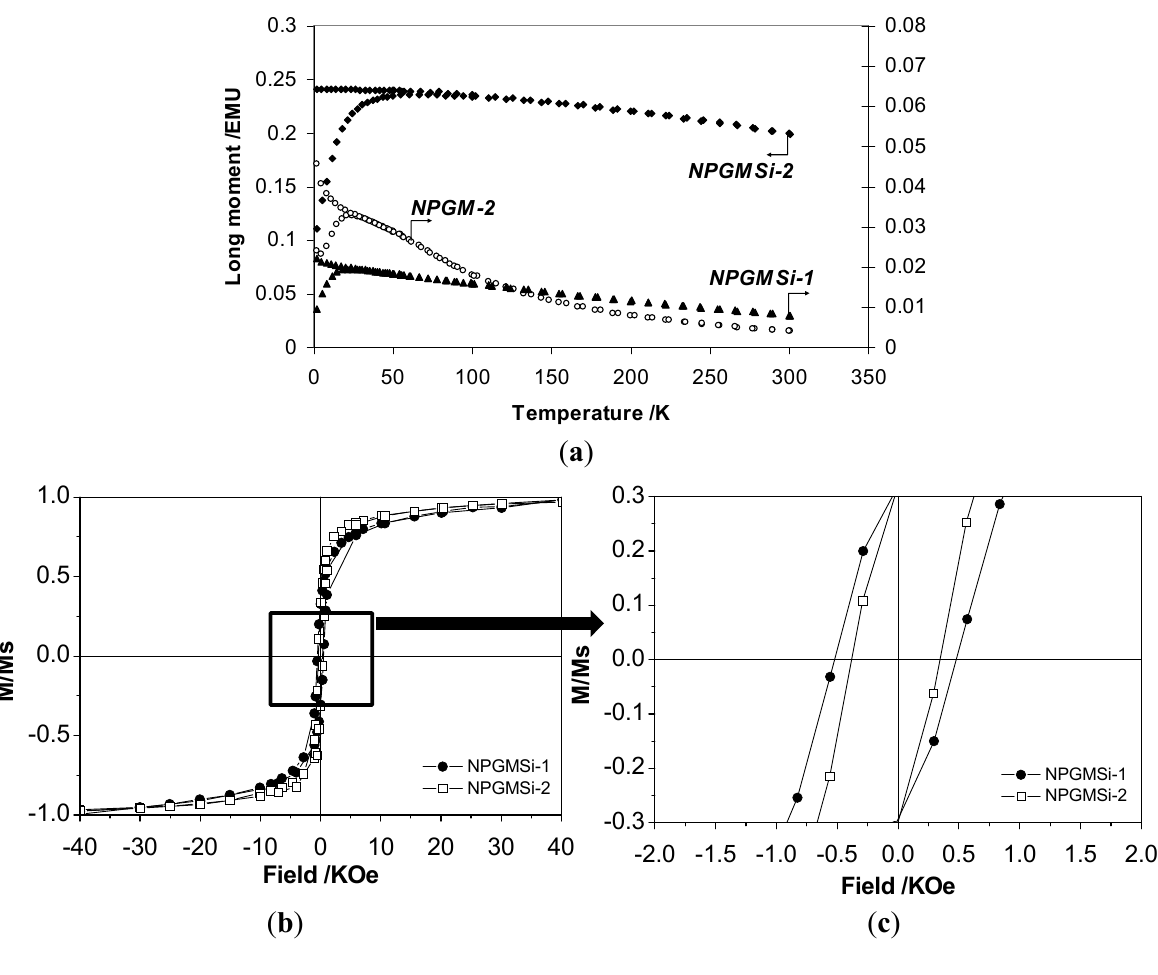
Figure 4. Magnetic properties of nanocomposites: ( a ) zero-field-cooling/field cooling (ZFC/FC)/ZFC susceptibility curves ( H = 500 Oe); ( b ) low and ( c ) high magnification of normalized magnetization ( M / M S ) vs. magnetic field ( T = 2